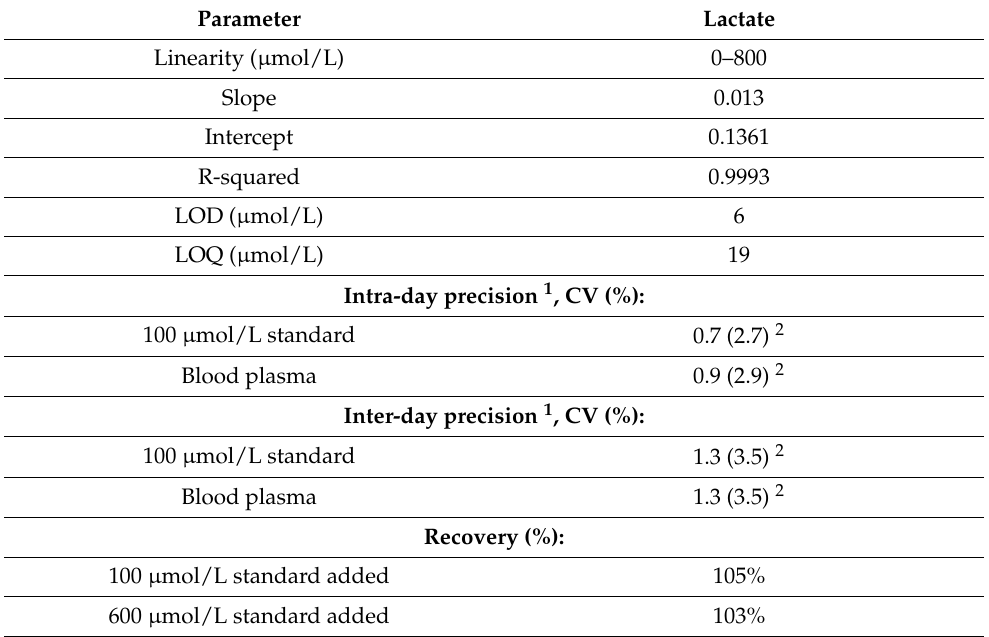
Table 1. Analytical parameters of the developed